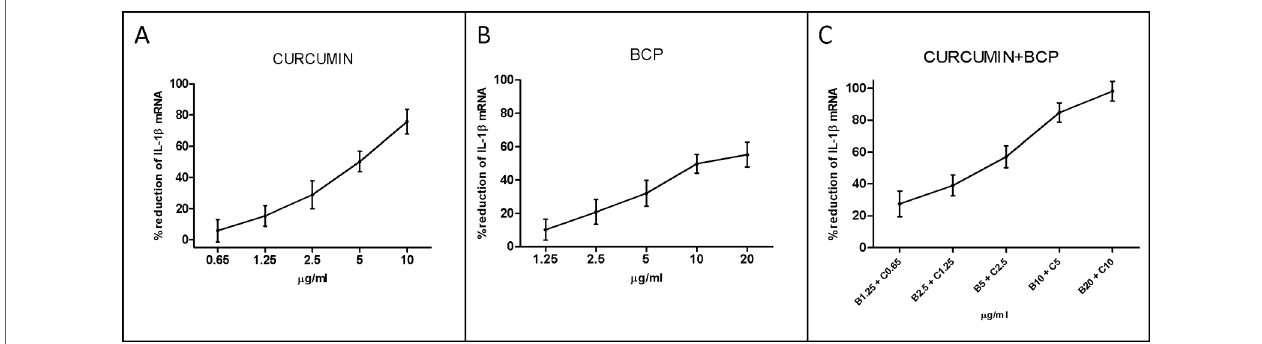
FIgURE 4 | Dose-response curve for curcumin (panel A ), BCP (panel B ) and BCP-curcumin in combination (panel C ). Data are expressed as % of reduction of IL-1β mRNA levels.